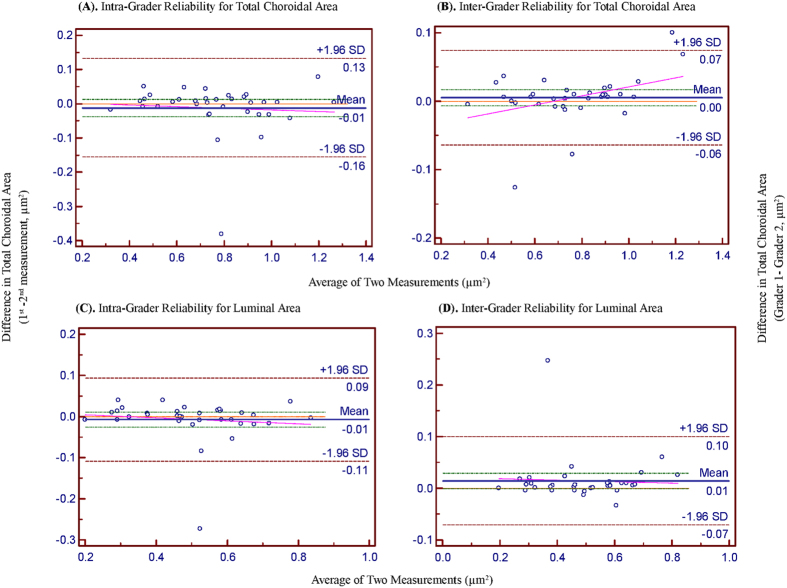
Bland Altman plots of total choroidal area and luminal area.(A) and (B) shows intra- and inter- rater reliability for total choroidal area respectively. (C) and (D) shows intra- and inter- rater reliability for luminal area respectively. For intra-rater reliability, the difference was calculated by the 1st measurement minus the 2nd measurement. Pink dashed line represents regression line of difference between 1st and 2nd measurements. For inter-rater reliability, the difference was calculated by the grader 1 measurement minus the grader 2 measurement. Pink dashed line represents regression line of difference between the two graders measurements.